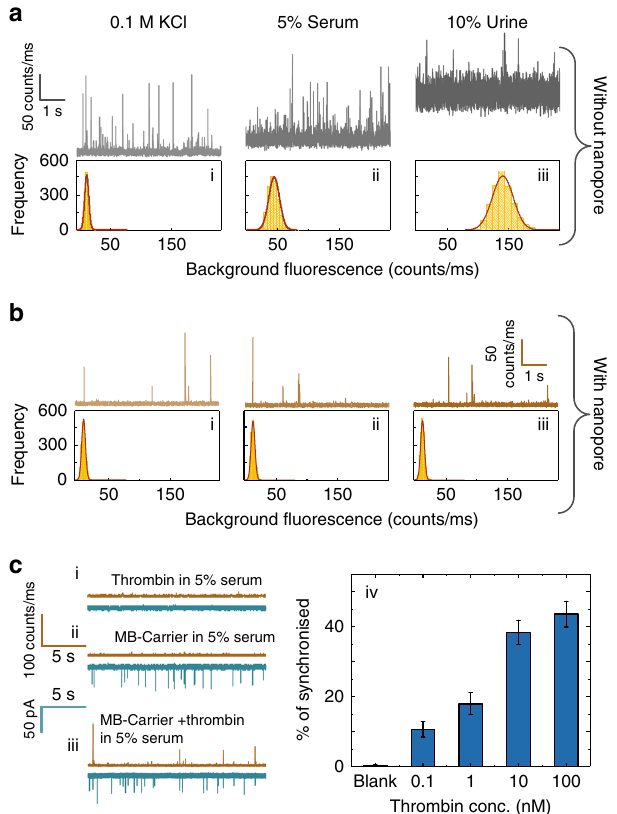
Fig. 5 Sensing of cDNA and protein targets in human serum and urine. a Photon time traces for the detection of cDNA bound to the MB-Carrier in (i) 0.1 M KCl (pH = 8), (ii) 0.1 M KCl + 5% human serum, (iii) and 0.1 M KCl + 10% urine. Conventional confocal single-molecule methods were used (i.e. droplet on a coverslip). b Comparable traces to those shown in ( a ) using a nanopore. A signi fi cant decrease in background fl uorescence is observed in part due to the solution being con fi ned to inside the nanopipette. The reservoir outside the nanopipette only contains a 0.1 M KCl buffer solution. Translocation experiments were performed at − 300 mV and in all cases, the laser power was 193 ± 6 μ W. c Photon and current time traces are shown for the translocation of (i) thrombin in 5% serum, (ii) serum. The MB-Carrier and thrombin concentration was 30 pM and 1 nM respectively. (iv) Percent synchronisation between the optical and electrical channels for thrombin bound to the MB-Carrier at concentrations ranging from 0.1 to 100 nM. Error bars indicate the standard deviation for